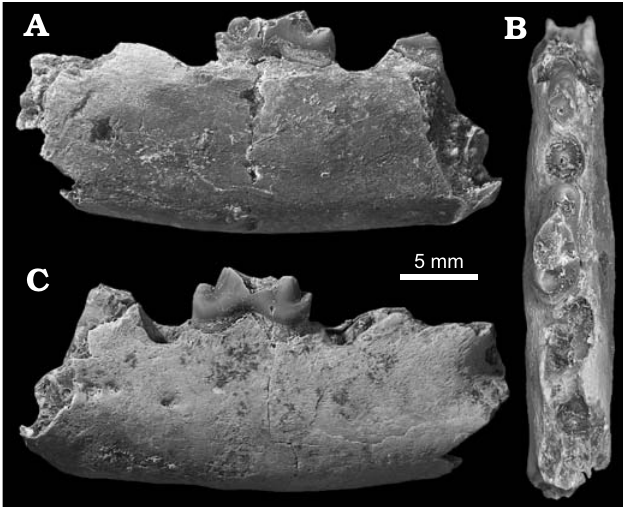
Fig. 8. Felid carnivoran Pseudaelurus sp. from the Eastgate LF, basal-most unit of the Monarch Mill Formation, Barstovian (Miocene), Churchill County, Nevada, USA. UCMP 141531, partial left dentary with anterior root of p3 and partial p4, in lingual ( A ), occlusal ( B ), and labial ( C ) views.